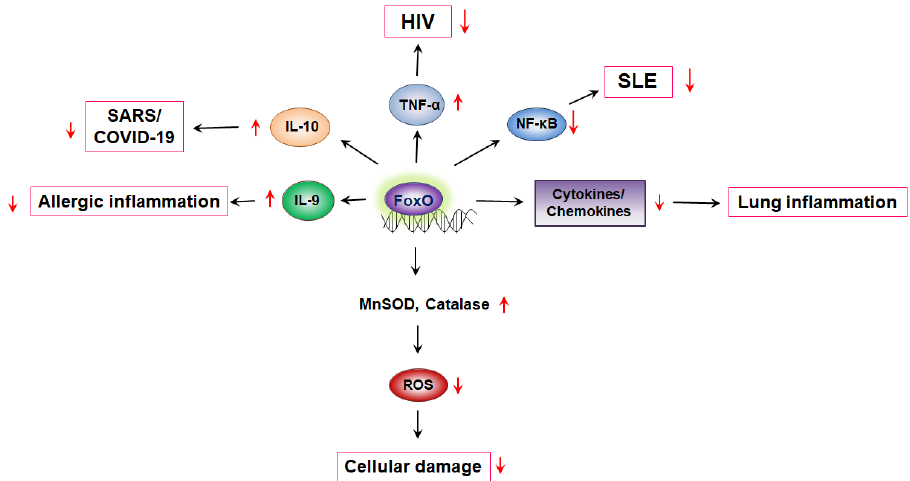
Figure 1. FoxO-mediated cytokine production regulates diseases. FoxO, Forkhead transcription fac- tor O; MnSOD, manganese superoxide dismutase; ROS, reactive oxygen species; NF- κB, nuclear factor kappa B; SLE, systemic lupus erythematosus; TNFα, tumor necrosis factor alpha; HIV, human immunodeficiency virus; SARS, severe acute respiratory syndrome. Table 1. Effect of pharmacological compounds in various